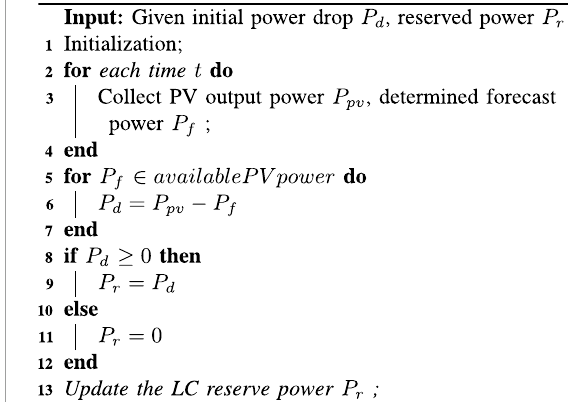
Algorithm1. LC − pseudocode.